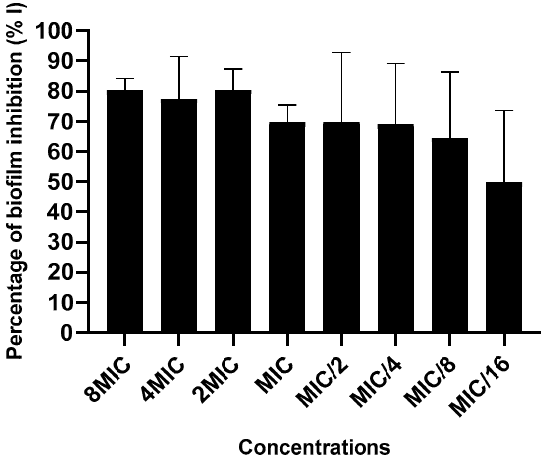
Figure 6. Action of P. huayllabambana n-hexane fraction on S. enterica biofilm formation. MIC: minimum inhibitory concentration. Data expressed as mean ± SD ( p < 0.05).